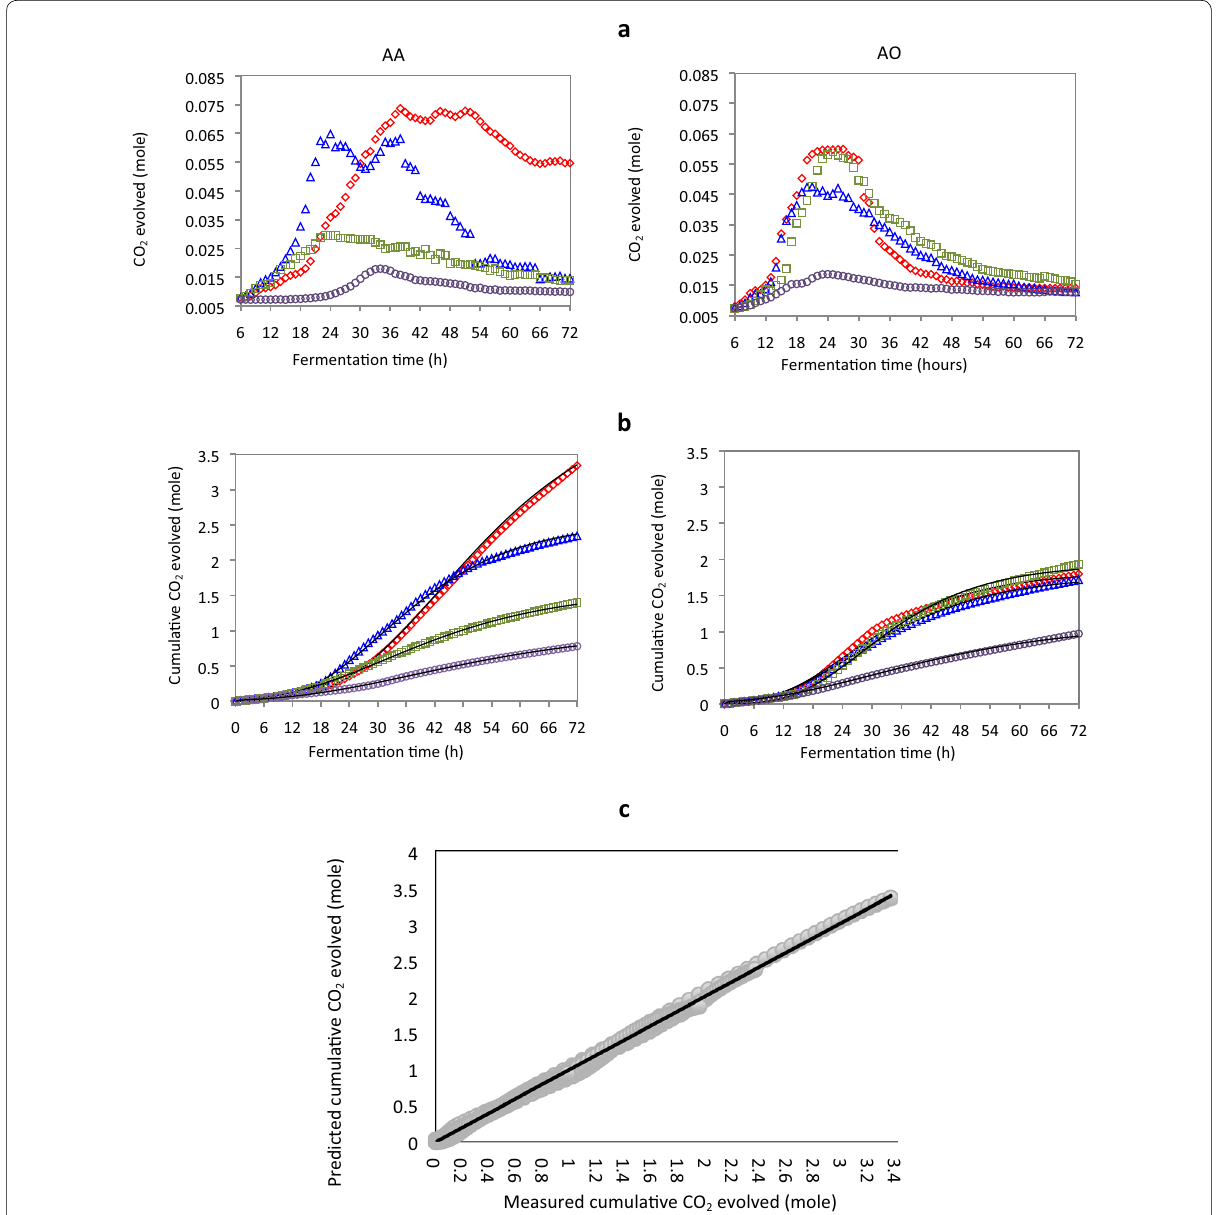
Measured cumula(cid:4)ve CO 2 evolved (mole) Fig. 4 a Real-time CO 2 evolved and b variation of cumulative CO 2 evolved with time at different moisture content arrangements at air flow rate 2 L/ min during the growth of A. awamori [AA] and A. oryzae [AO] on wheat bran in multi-stacked tray SSB. Symbols represent experimental data. The Gompertz model is shown as a solid line. [diamond]: Exp. 1; [triangle]: Exp. 2; [square]: Exp. 3 and [circle]: Exp. 4. c Correlation between measured and predicted cumulative CO 2 evolved data of A. awamori and A. oryzae from all experiments conducted using wheat bran in multi-stacked circular tray SSB [grey